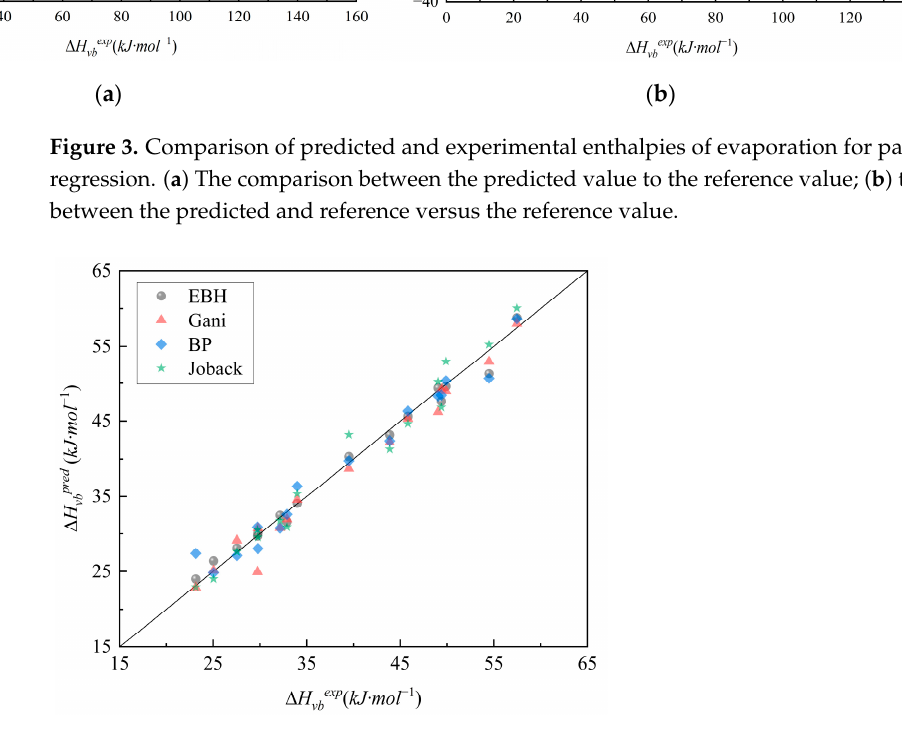
Figure 4. Comparison of predicted and experimental enthalpies of evaporation not involved in the regression.